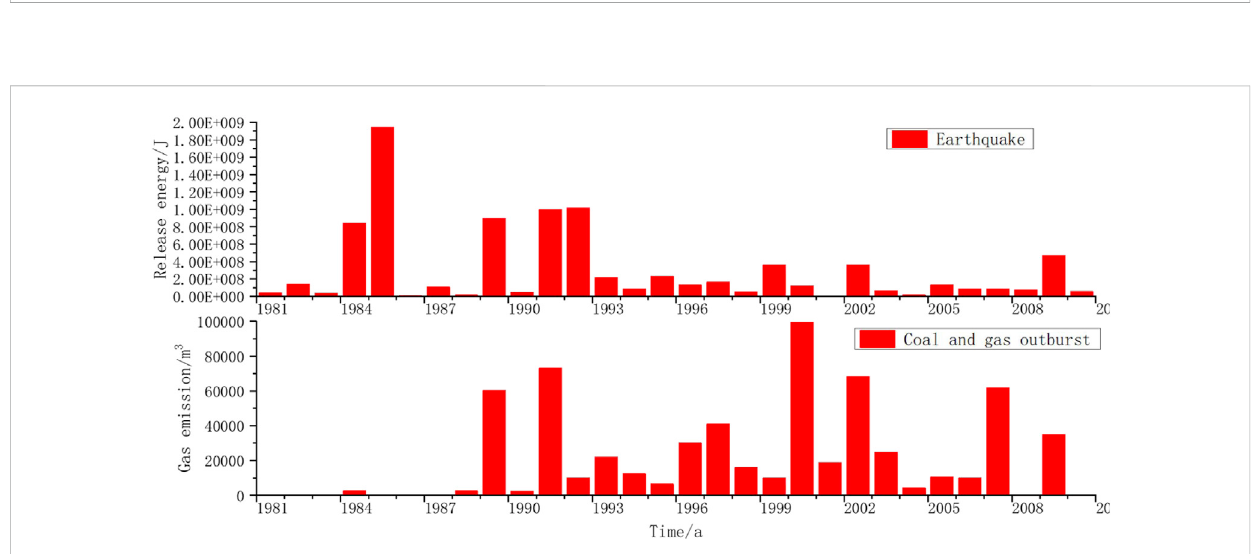
FIGURE 9 Histogram of annual outburst gas volume and annual release energy of natural earthquake of coal and gas outburst in Pingdingshan eastern mining area.